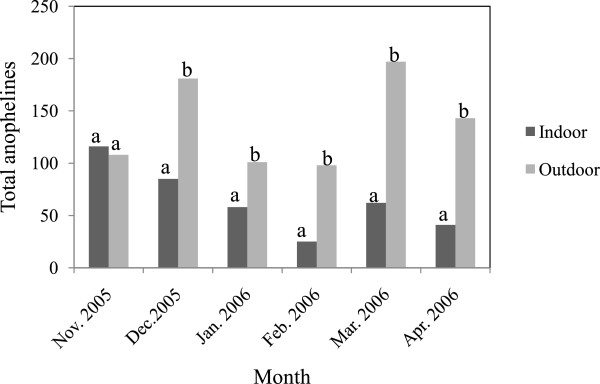
Monthly captures and comparisons of total anophelines by Human Landing Catches during the dry season. Bars followed by same letters are not significantly different at p = 0.05.